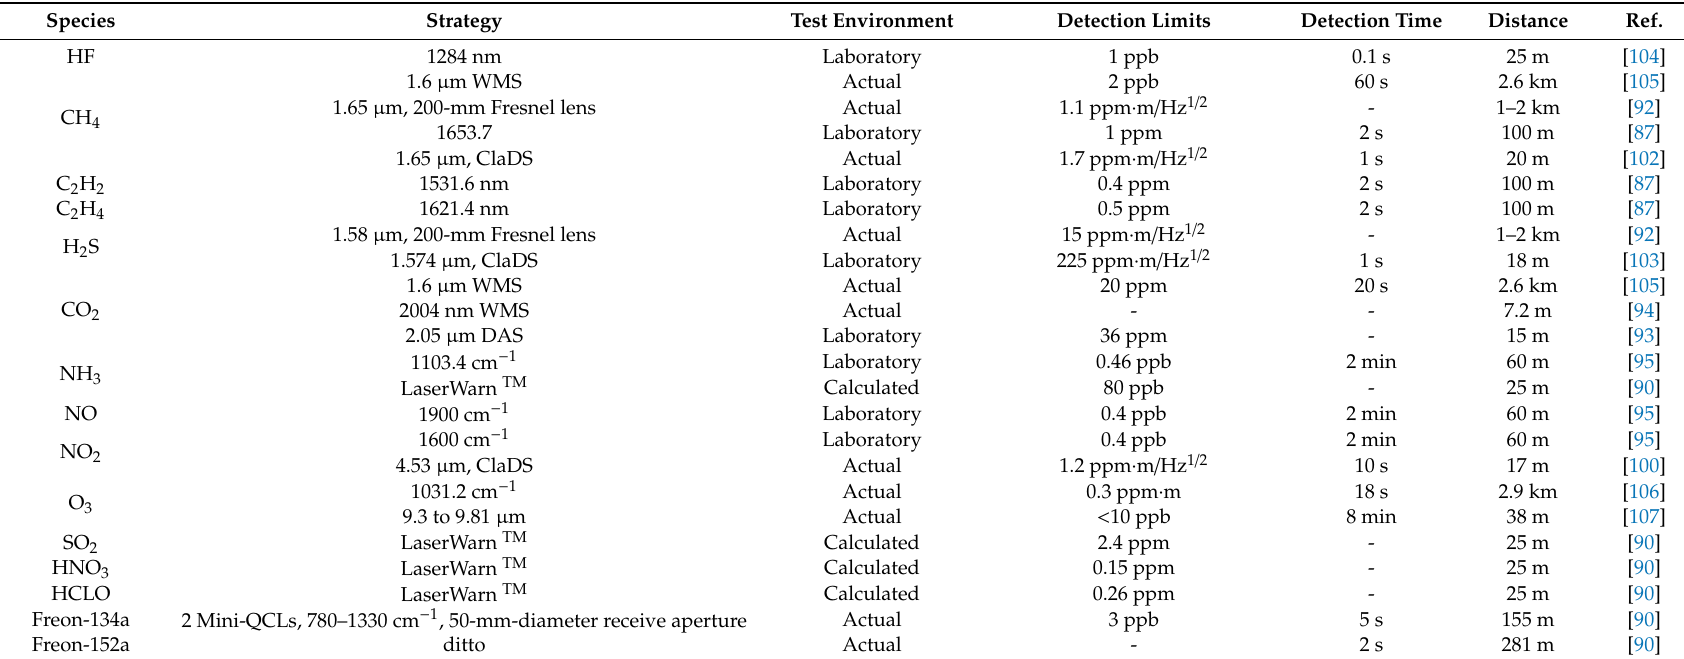
Table 2. Recent advances in TDLAS stando ff detections with